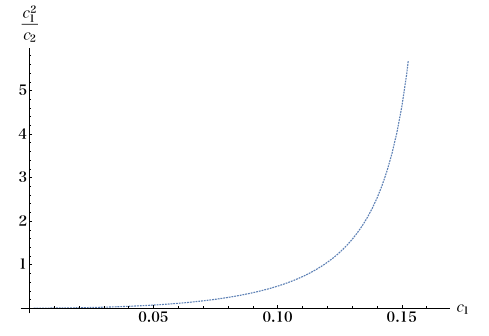
=c 2 for the choice (cid:14) = 6 = 1